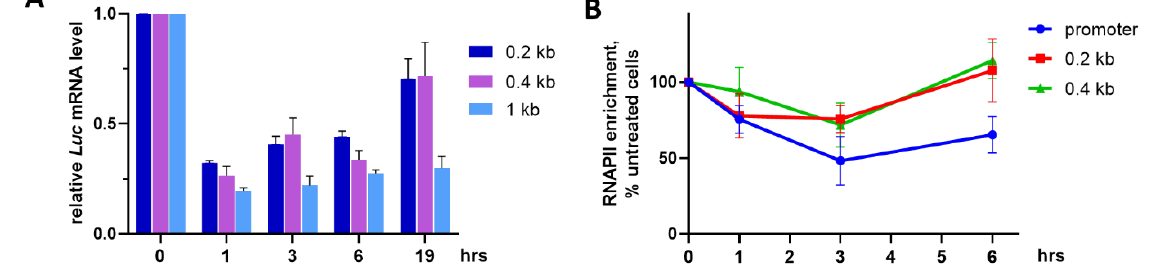
Figure 3. Time- and size-dependent restoration of transcripts after OA washing. HEK293T-CMVwt- Luc cells were treated 100 nM OA for 3 h, washed with saline, and incubated in OA-free medium for indicated time intervals. ( A ) qRT-PCR analysis of Luc mRNAs of different length. Values (normalized to RPLP0 signal) are relative to those prior to OA washing (0 h). ( B ) Abundance of total RNAPII on the Luc gene (ChIP assays).